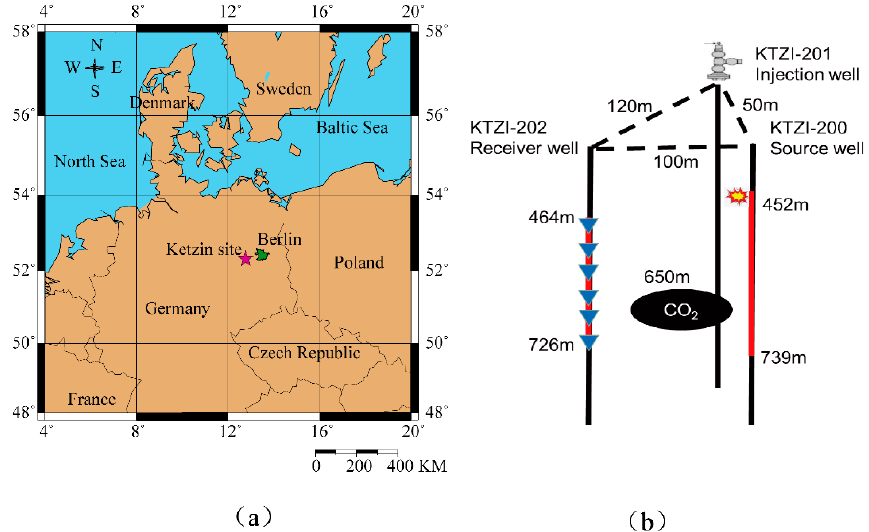
Figure 14. ( a ) Location of the Ketzin pilot site, west of Berlin, Germany. ( b ) A sketch of the geometry of the cross-well surveys at the Ketzin site.